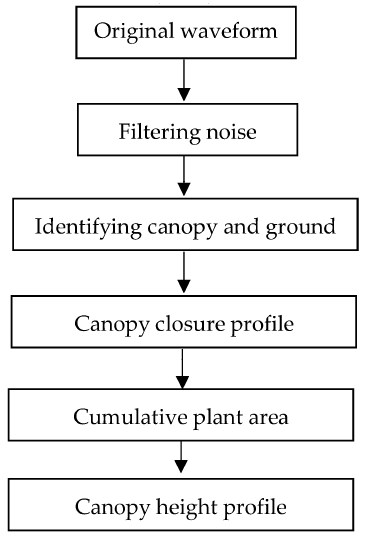
Figure 3. The flowchart of deriving the CHP from Tomoradar waveforms.